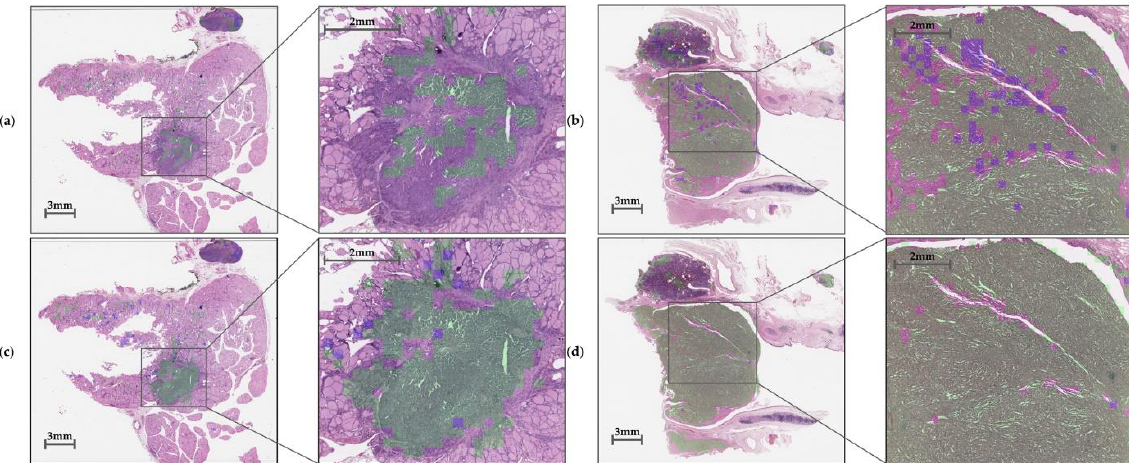
Figure 9. Inference results for TERT based on ( a ) negative and ( b ) positive cases without color transformations (as a base model) and ( c ) negative and ( d ) positive cases with color transformations. True positive TERT predictions are marked with a green color, whereas all others are indicated with a purple color. Table 3. Inference results for the cascaded CNN + CRNN(ResNet152+LSTM)